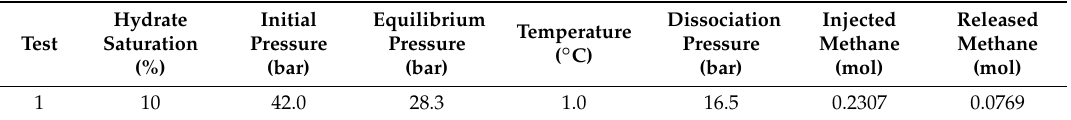
Table 3. Experimental tests and results.